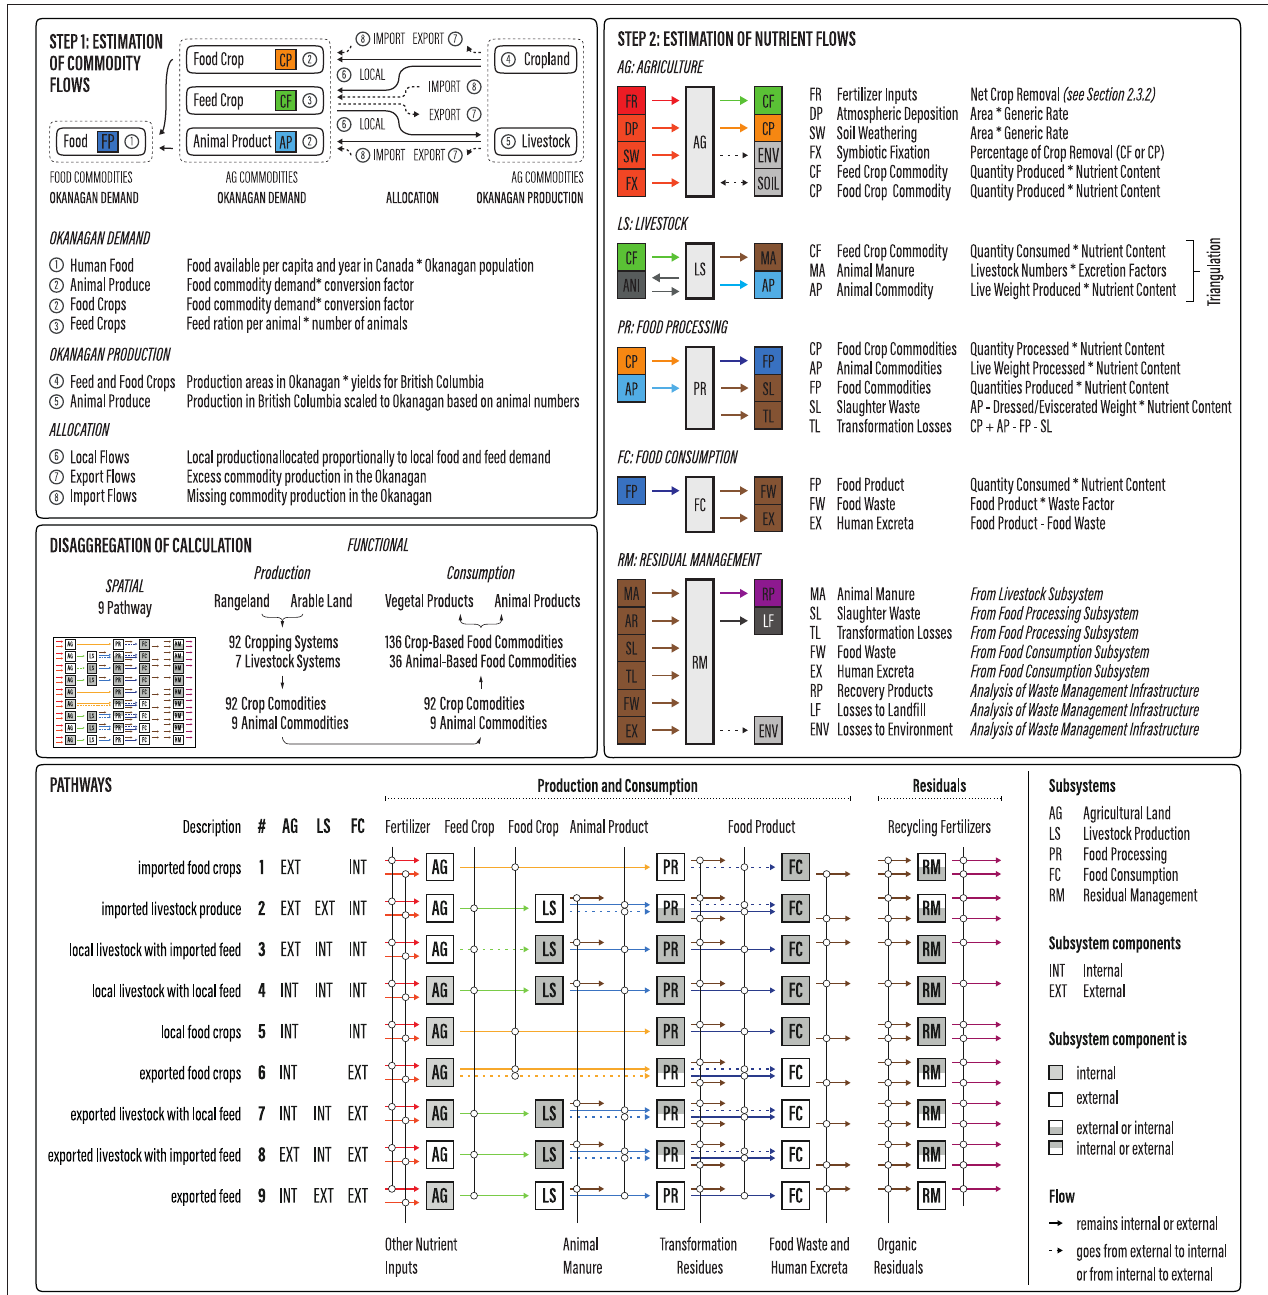
FIGURE 4 | Procedure for estimating nutrient flows. The first step was to estimate commodity flows. The second step was to translate commodity flows into nutrient flows. Calculations were carried out separately per commodity and for nine pathways from crop production to food consumption (see “disaggregation of calculation”). Each pathway describes a unique combination of where the crop and livestock commodities are produced, and the food commodities are consumed (see “pathways”). The idea with these separate pathways was to be able to track nutrients nutrients from crop production to organic residual generation as a function of whether certain subsystem components are internal or external to the Okanagan. Figure adapted from Harder et al. (2021a).